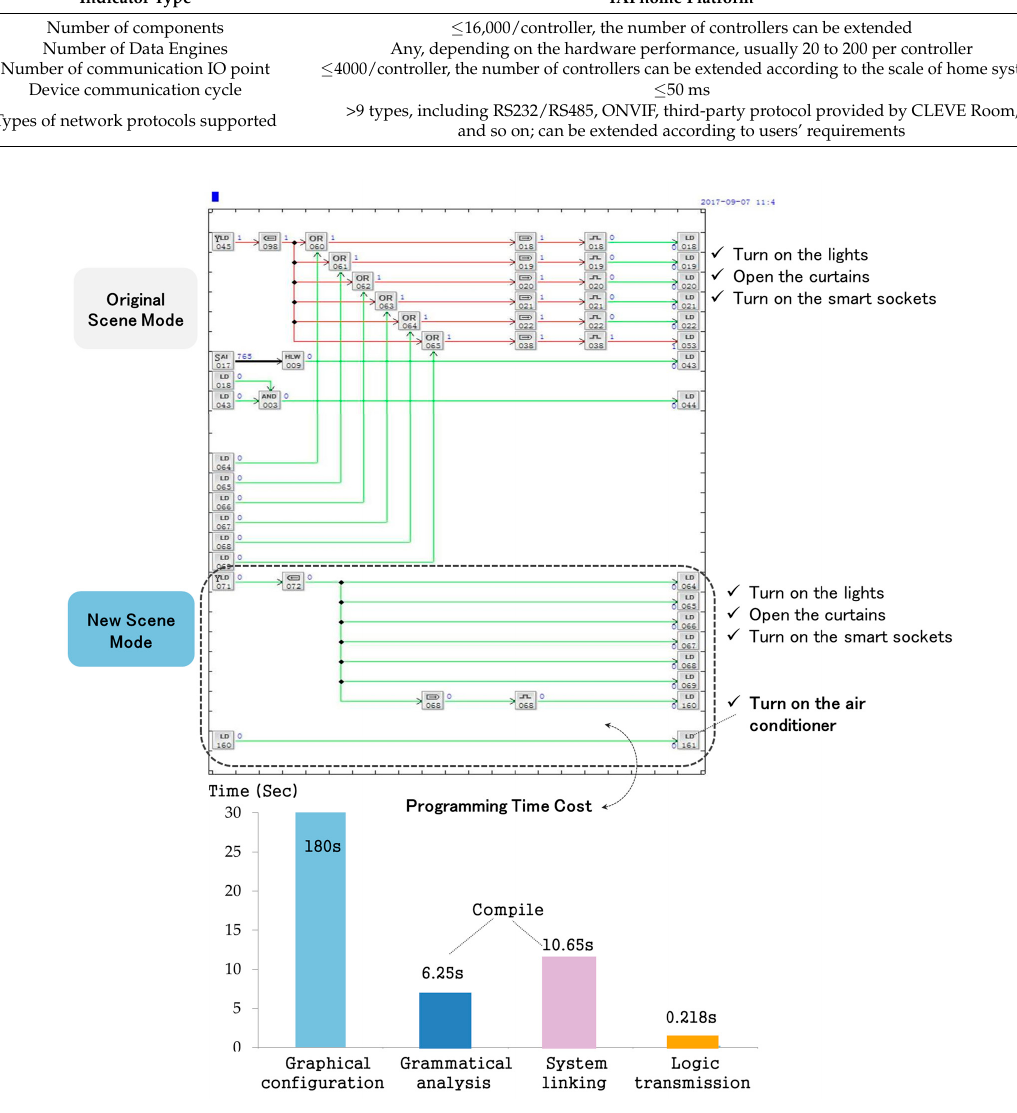
Figure 14. An example of the scene mode extension.